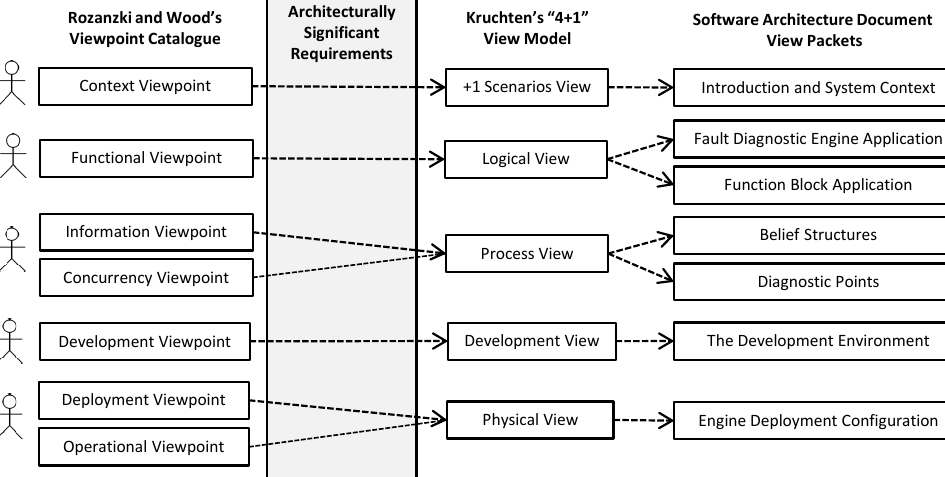
Figure 3. From viewpoints, architecturally-significant requirements and views to view